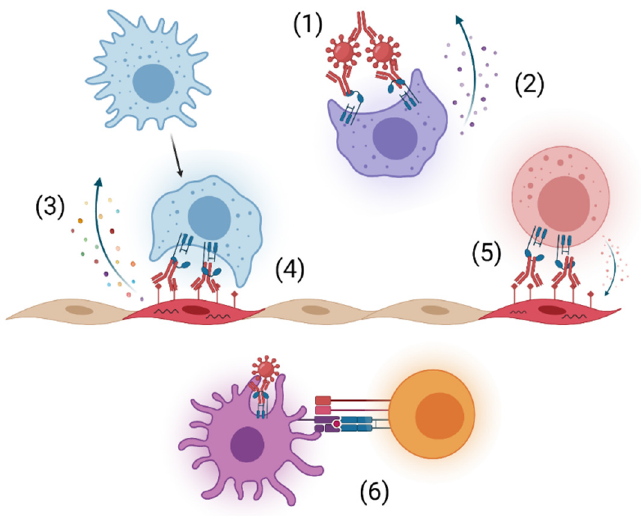
Figure 1. Potential Fc-Fc γ R interactions for enhanced protection with mAb administration. ( 1 ) Op- sonization of viral-antibody immune complexes and clearance by phagocytic cells. ( 2 ) Altered activation and pro-inflammatory response from phagocytic cell. ( 3 ) Secretion of chemokines and cytokines to promote cellular recruitment and modify inflammation. ( 4 ) Clearance of infected cells through antibody-dependent cellular phagocytosis (ADCP) by phagocytic cells. ( 5 ) Removal of in- fected cells through antibody-dependent cellular cytotoxicity (ADCC) by effector cells. ( 6 ) Enhanced T cell activation through Fc-Fc γ R mediated DC maturation. Created with BioRender.com .